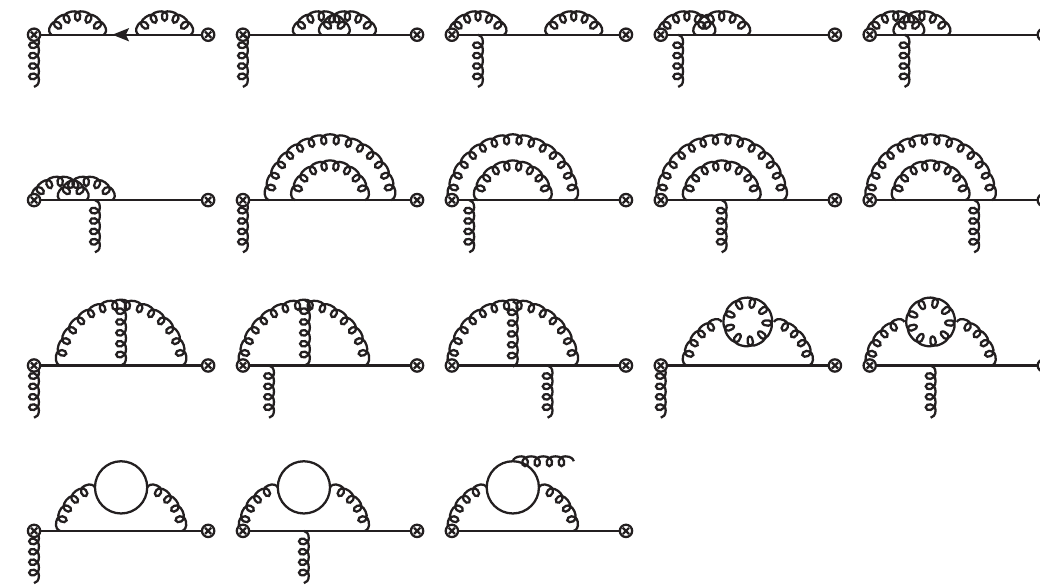
Figure 2: Feynman diagrams contributing to the jet function at two-loop order in light-cone gauge. The diagrams portrayed here also contribute to the photon jet function under the exchange of the external gluon by an external photon. Note that the fermion in the inserted loop can run in both directions (last